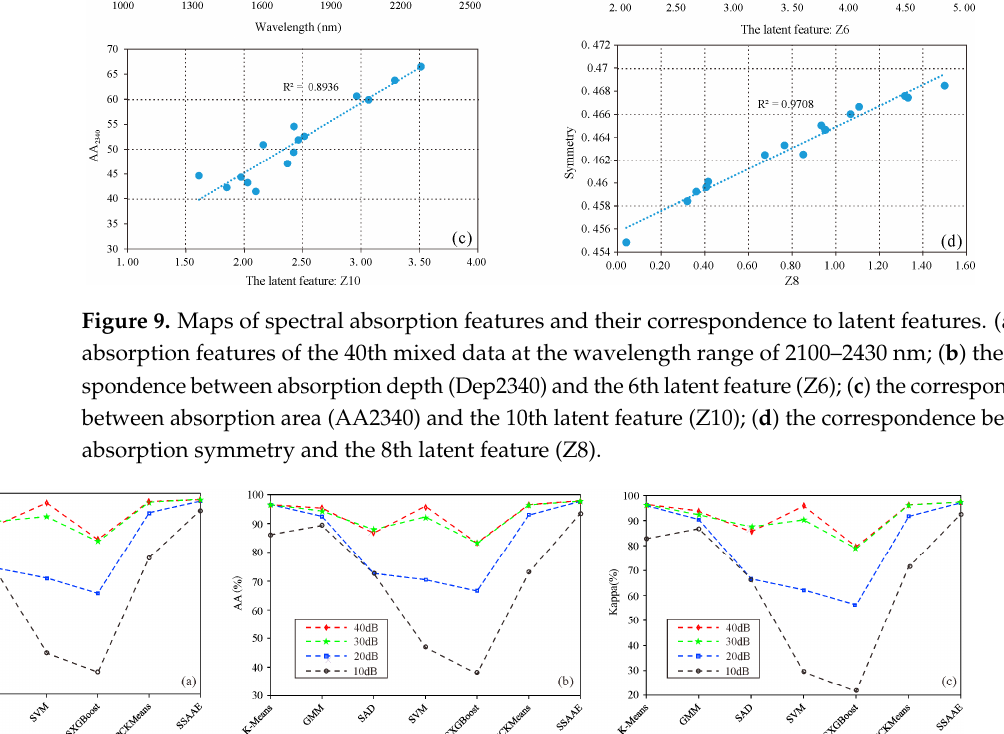
Figure 10. Comparison of classification results using different methods under the synthetic dataset with diverse SNRs. ( a ) OA; ( b ) AA; ( c ) Kappa.